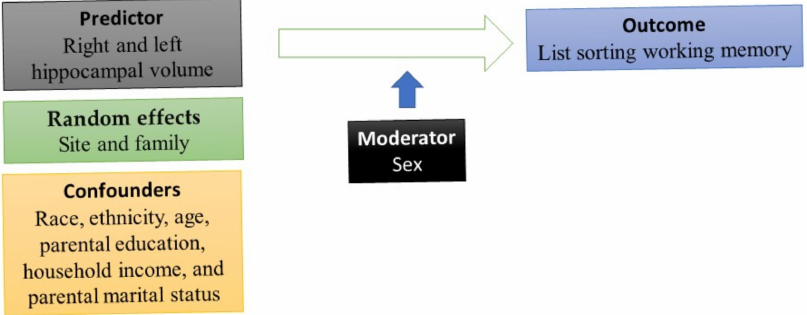
Figure 1. The study schematic diagram (main effects of hippocampus volume, sex, and covariates were tested in Model 1 ; interaction between sex and hippocampus volume was tested in Model 2